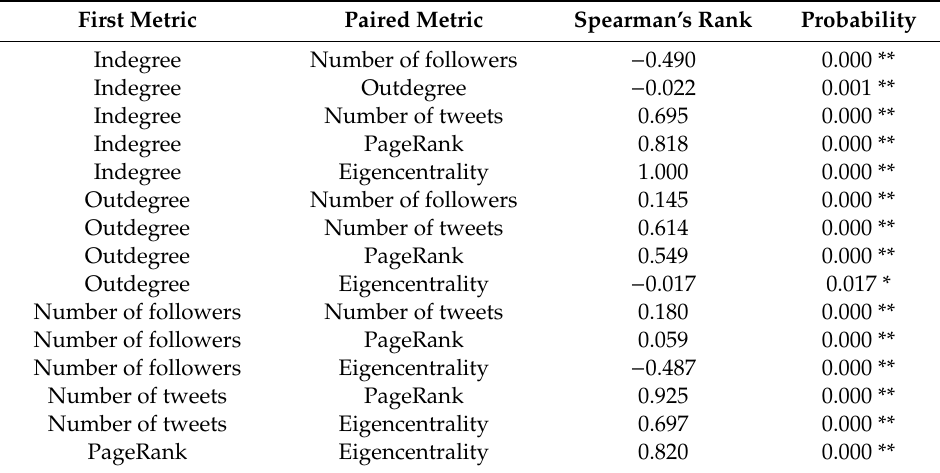
Table 2. Spearman’s ranks between